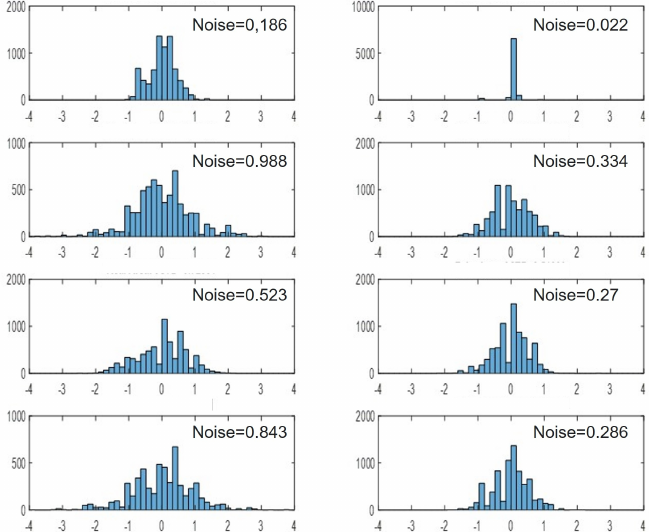
Figure 11. Noise histogram for a real face ( left column ) and a masked face ( right column ) taken at 4 different regions on the face: ( top to bottom ); forehead, nose, chin and cheek. Note the difference in noise pattern between the real and masked